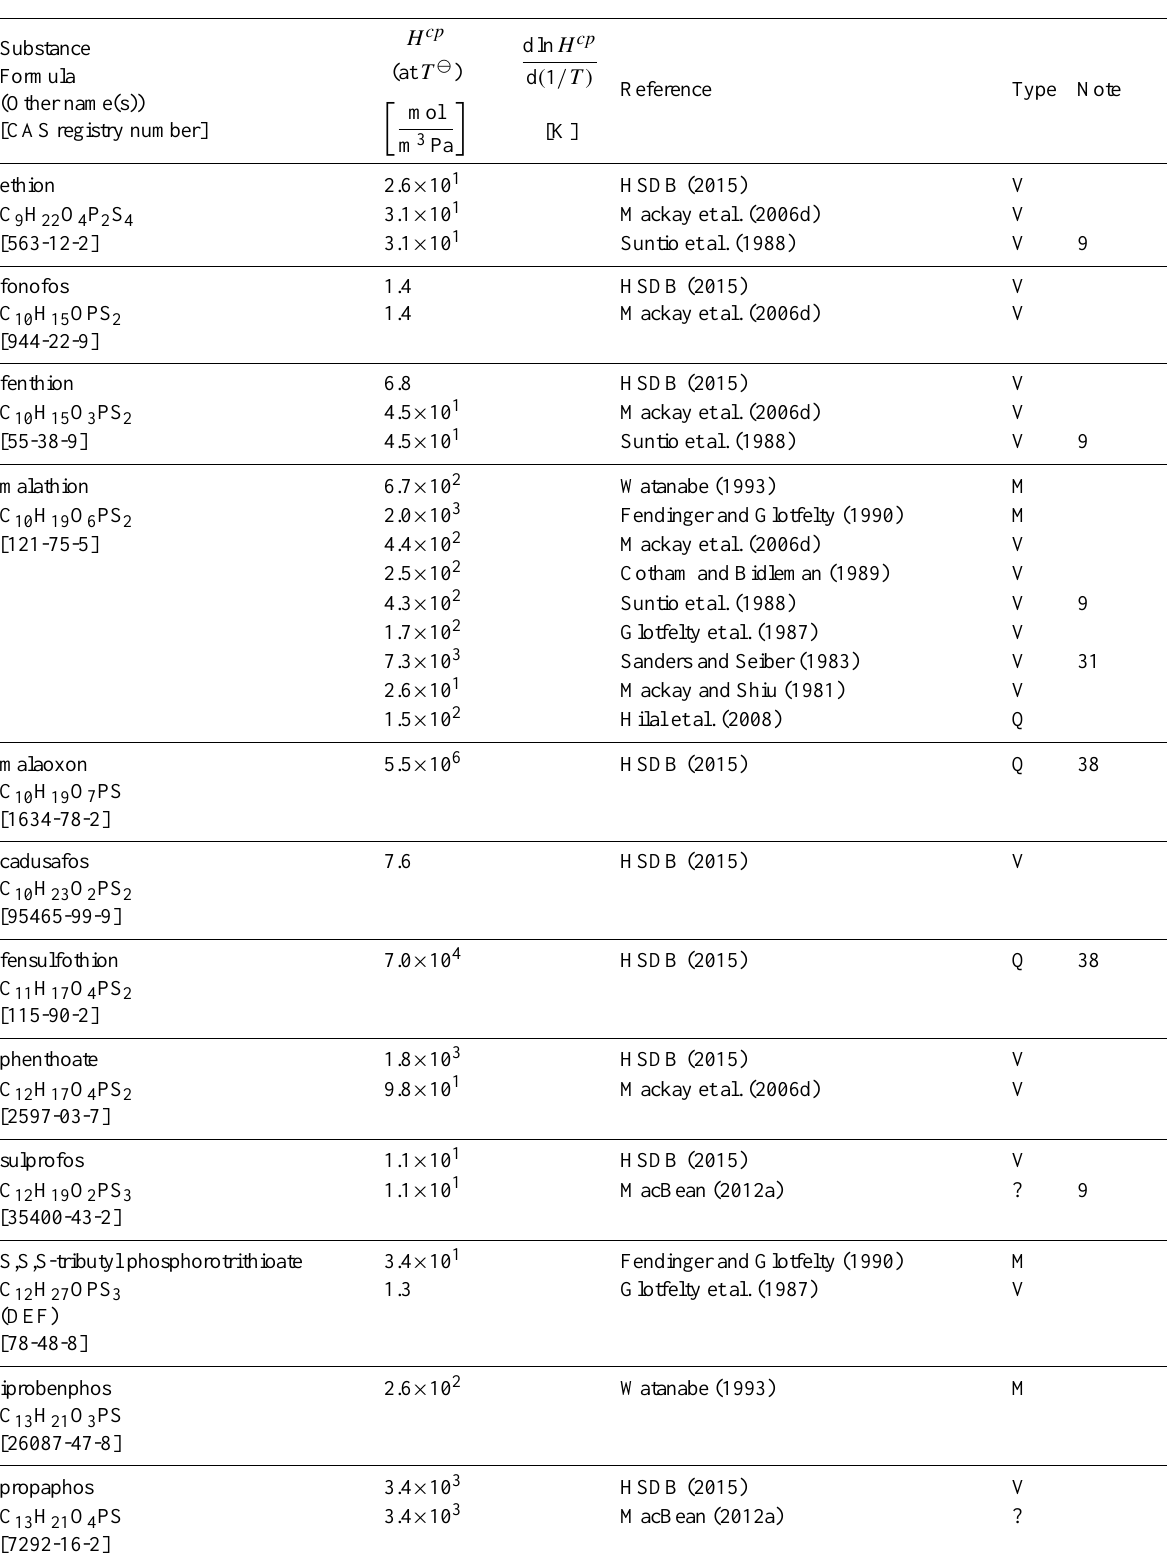
Table 6: Henry’s law constants for water as solvent